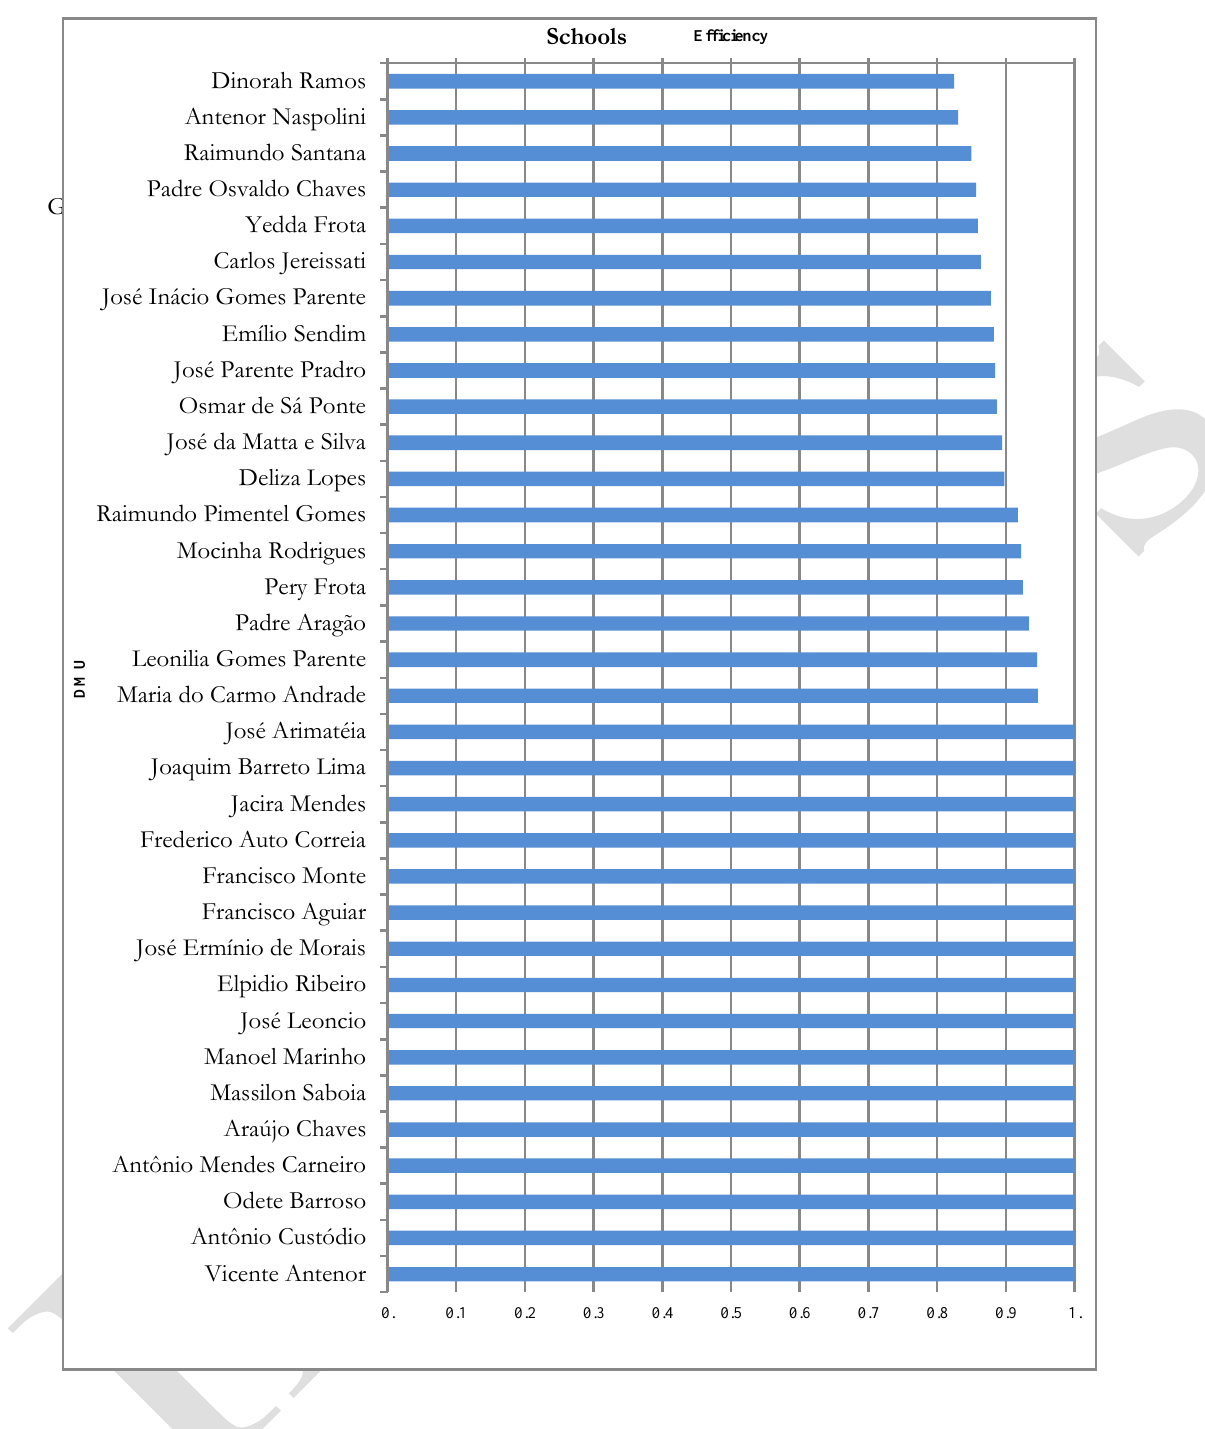
Graphic 1- Relative Efficiency Border of the 34 DMUs analyzed in